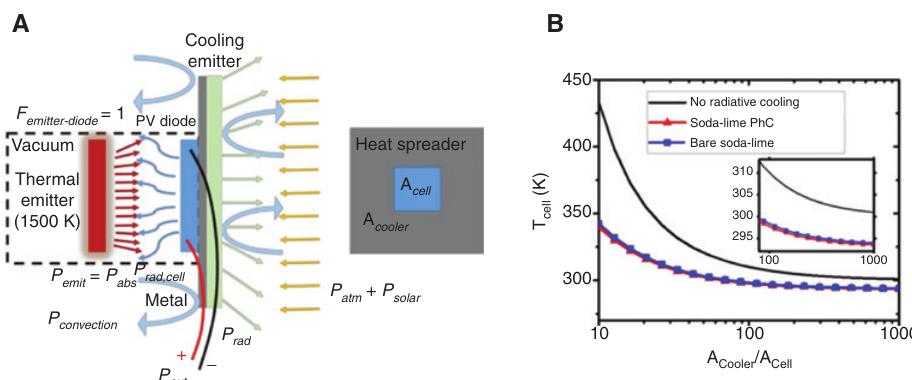
Figure 11: (A) The design of an outdoor TPV system with radiative cooling. The thermal emitter and PV cell are both enclosed in a vacuum for mutual thermal isolation. The area of the radiative cooler and heat spreader is larger than that of the PV cell to improve cooling power. (B) Operating temperature of PV cell as a function of the cooler-to-cell area ratio. The convection coefficient is set to be 2.5 W/(K m 2